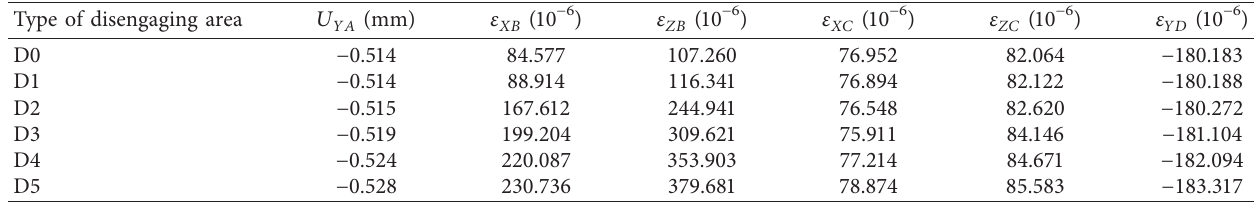
Table 5: Responses with interlayer bonding failure at the higher temperature.